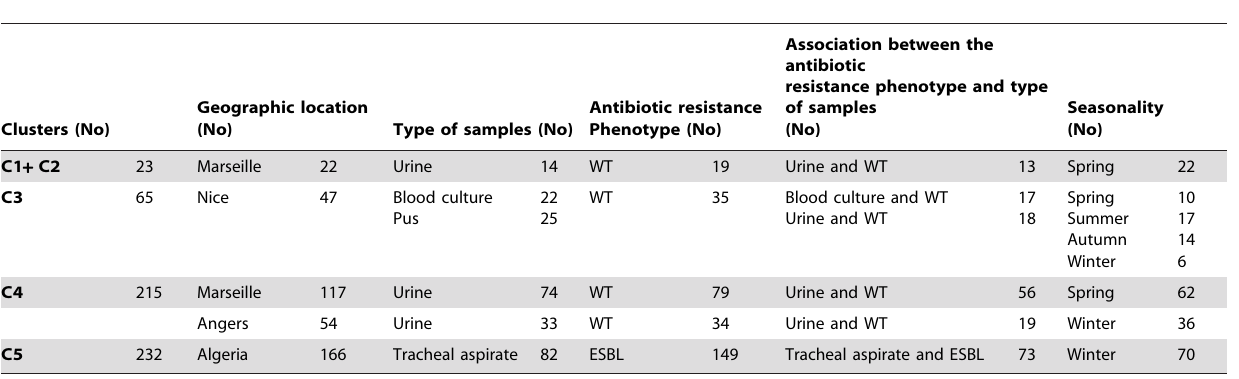
Table 4. Data mining analysis of Klebsiella pneumoniae MSP